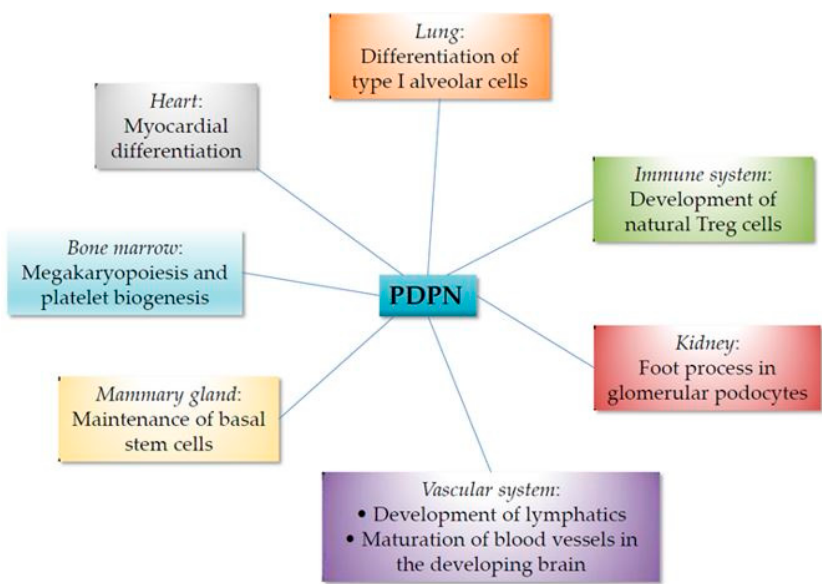
Figure 2. Involvement of podoplanin in embryonic development and